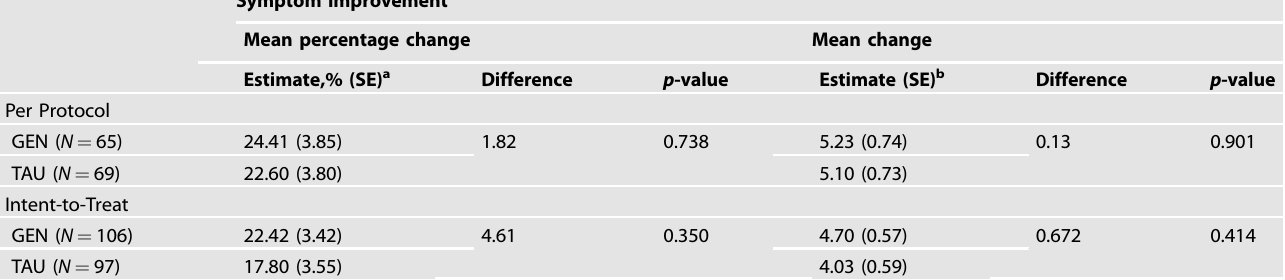
Table 2. Week 8 symptom improvement in the GEN and TAU treatment arms, according to HAM-D17. Symptom